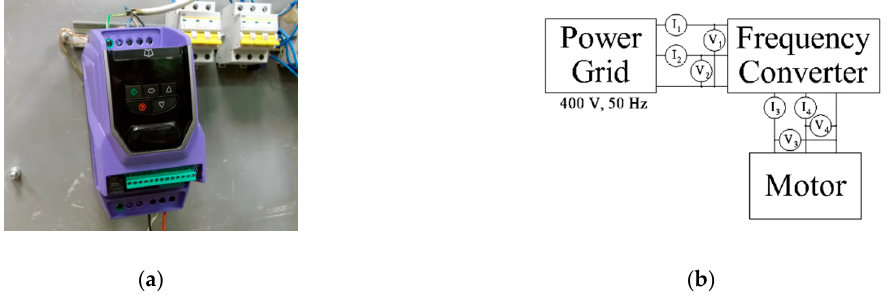
Figure 11. Converter testing: ( a ) Photograph of the FC; ( b ) Scheme of the test, I 1 – I 4 are current sensors; V 1 – V 4 are voltage sensors.